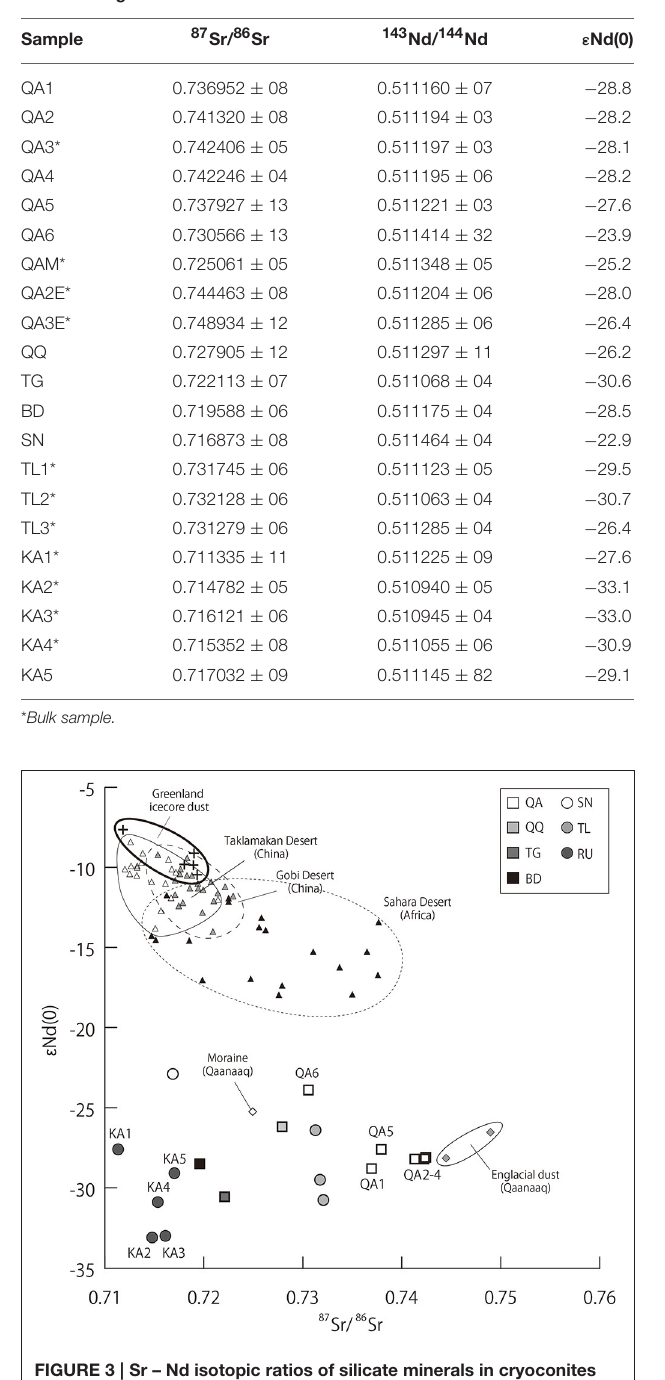
TABLE 3 | Sr and Nd isotopic ratio ( 87 Sr/ 86 Sr, 143 Nd/ 144 Nd and ε Nd (0), mean ± SD × 10 6 ) of cryoconites, moraine, and englacial dust on and around the glaciers in northwestern and southwestern Greenland.